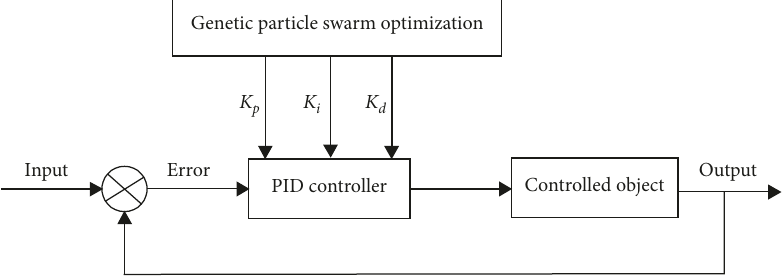
Figure 10: The control block diagram of the wave compensation system based on the genetic PID